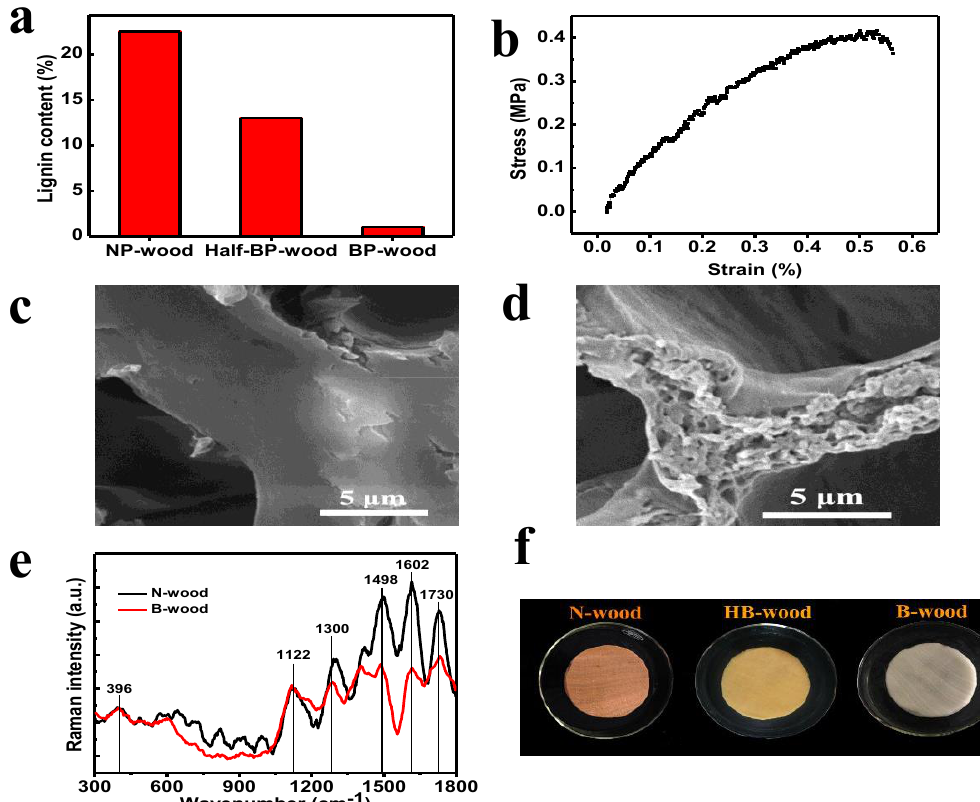
Figure 1. ( a ) Lignin content and ( b ) Mechanical strength of BP-wood in wet state. SEM images of cell wall corners and the middle lamella of ( c ) Natural basswood (N-wood) and ( d ) B-wood. ( e ) Raman characterization of N-wood, B-wood. The images were obtained through baseline corrected and normalized. ( f ) Photos of wood after removal of different content of lignin.